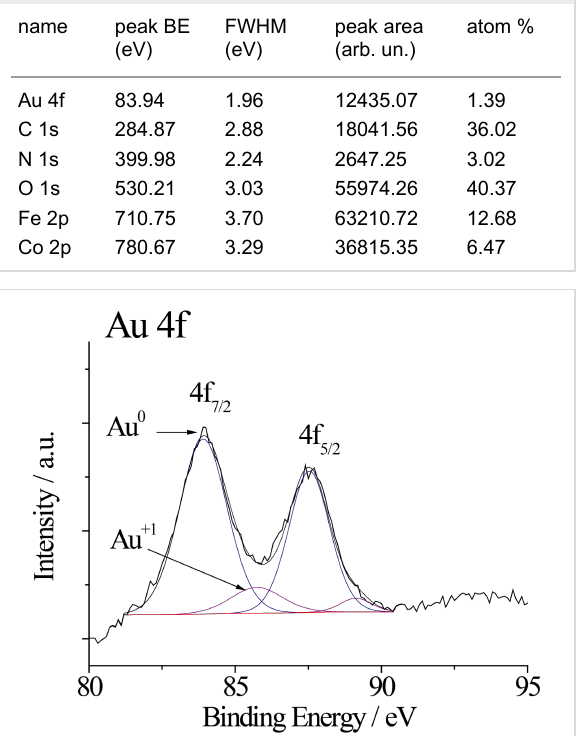
Table 1: Elemental composition of CoFe 2 O 4 @Met–Au NPs.